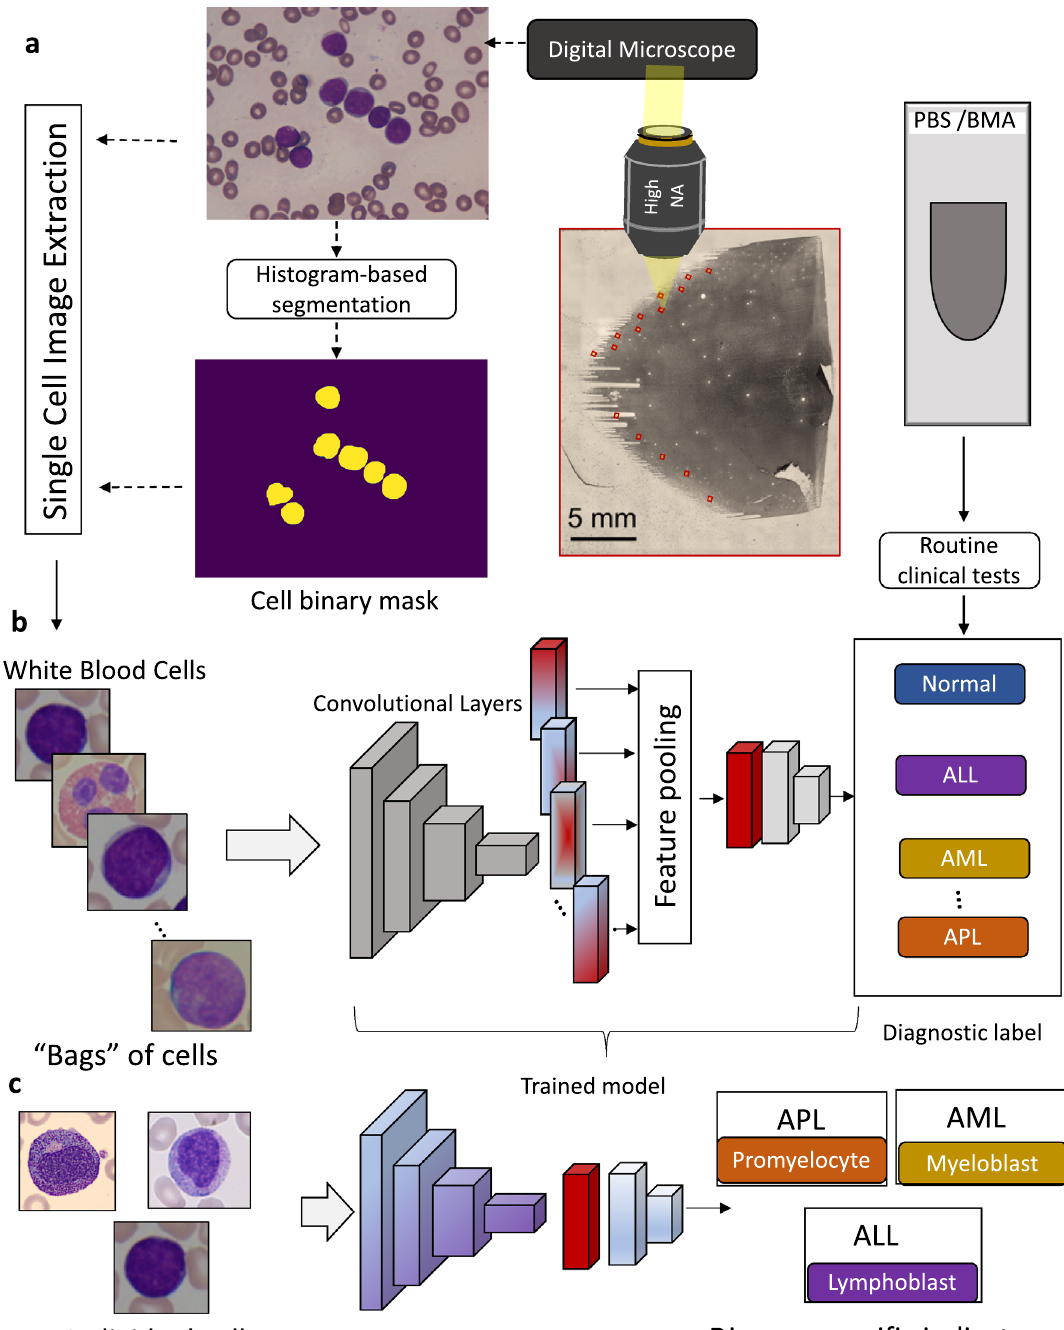
Figure 1. MILLIE approach. ( a ) Preprocessing and training data generation from a peripheral blood smear. Fields of view acquired with a high-NA objective lens (100×/1.4NA for blood films and 50×/0.55 for BMA) digital microscope are processed. A histogram-based segmentation 28 (see “Methods” section) was employed to generate binary masks corresponding to individual cells from the RGB images. These masks are further employed to crop individual patch images around each individual cell from the RGB images. ( b ) Training with weak labels. The extracted patches are passed through the convolutional neural network. Corresponding convolutional feature vectors are pooled together in one single feature vector (max pooling) followed by fully connected and classification layers. Weights of the model are optimized to predict the sample-level label available from routine clinical examinations. ( c ) Detecting morphological indicators. Once trained, individual cells can be passed one-by-one through the MILLIE models which classifies them as indicators for the specific disorders MILLIE learned to predict at a sample